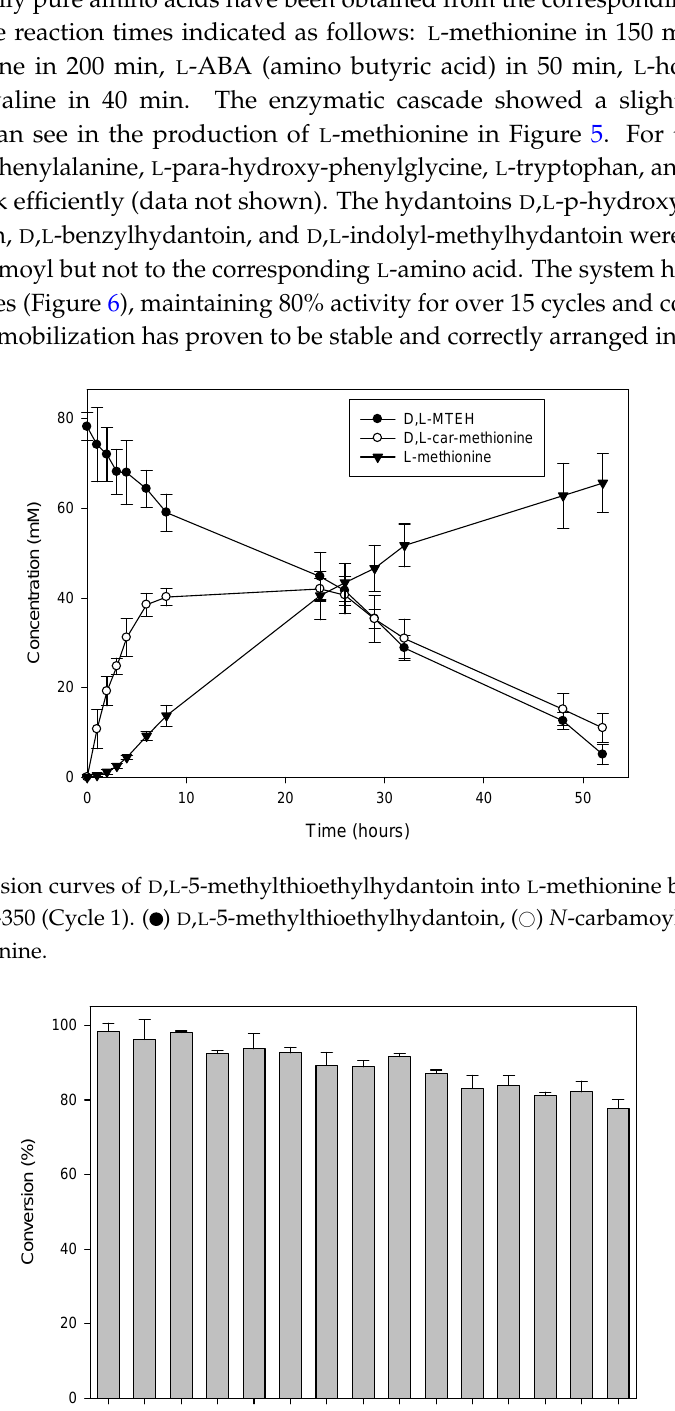
Figure 6. Number of cycles of activity of the system following the standard reaction with D , L ‐ 5 ‐ methylthioethylhydantoin as substrate and the percentage of amino acid produced. The beads were gently washed with water between cycles.